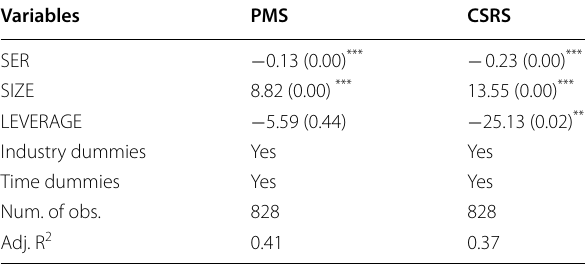
The table shows the outcome of estimating linear panel data regressions of MCS on social risk management. Significance at the 1 and 5% levels is indicated by *** and **, respectively (two-tailed